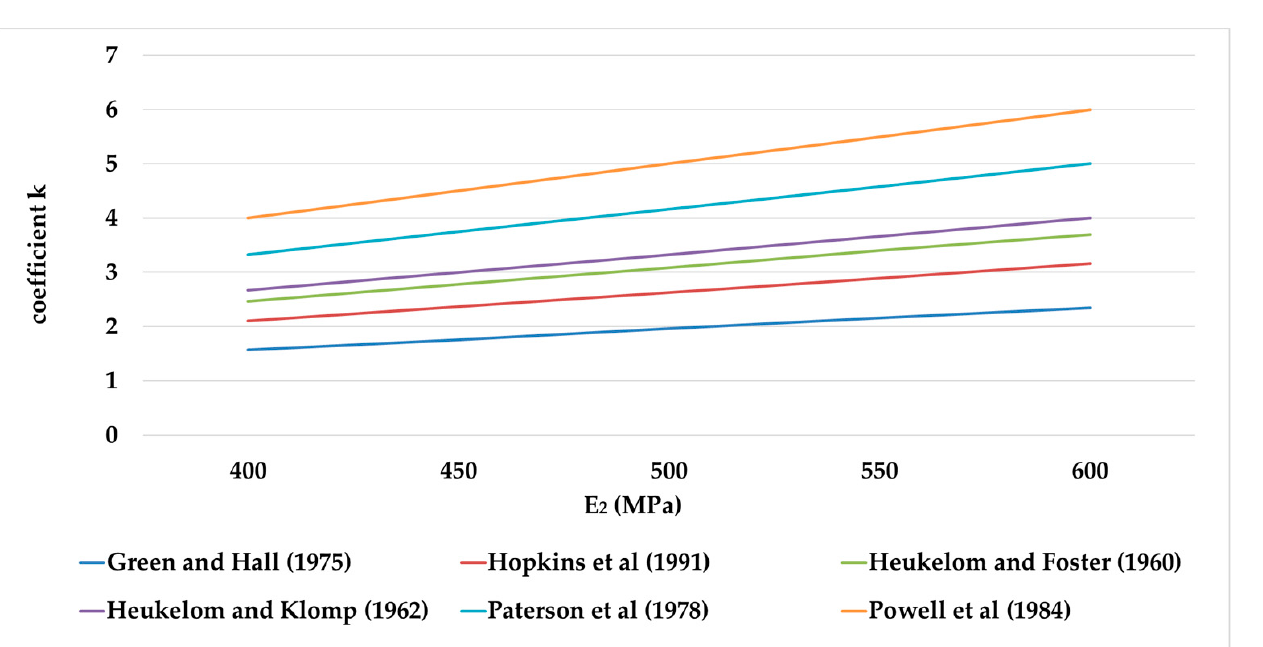
Figure 7. Comparison of k from the reviewed correlations.